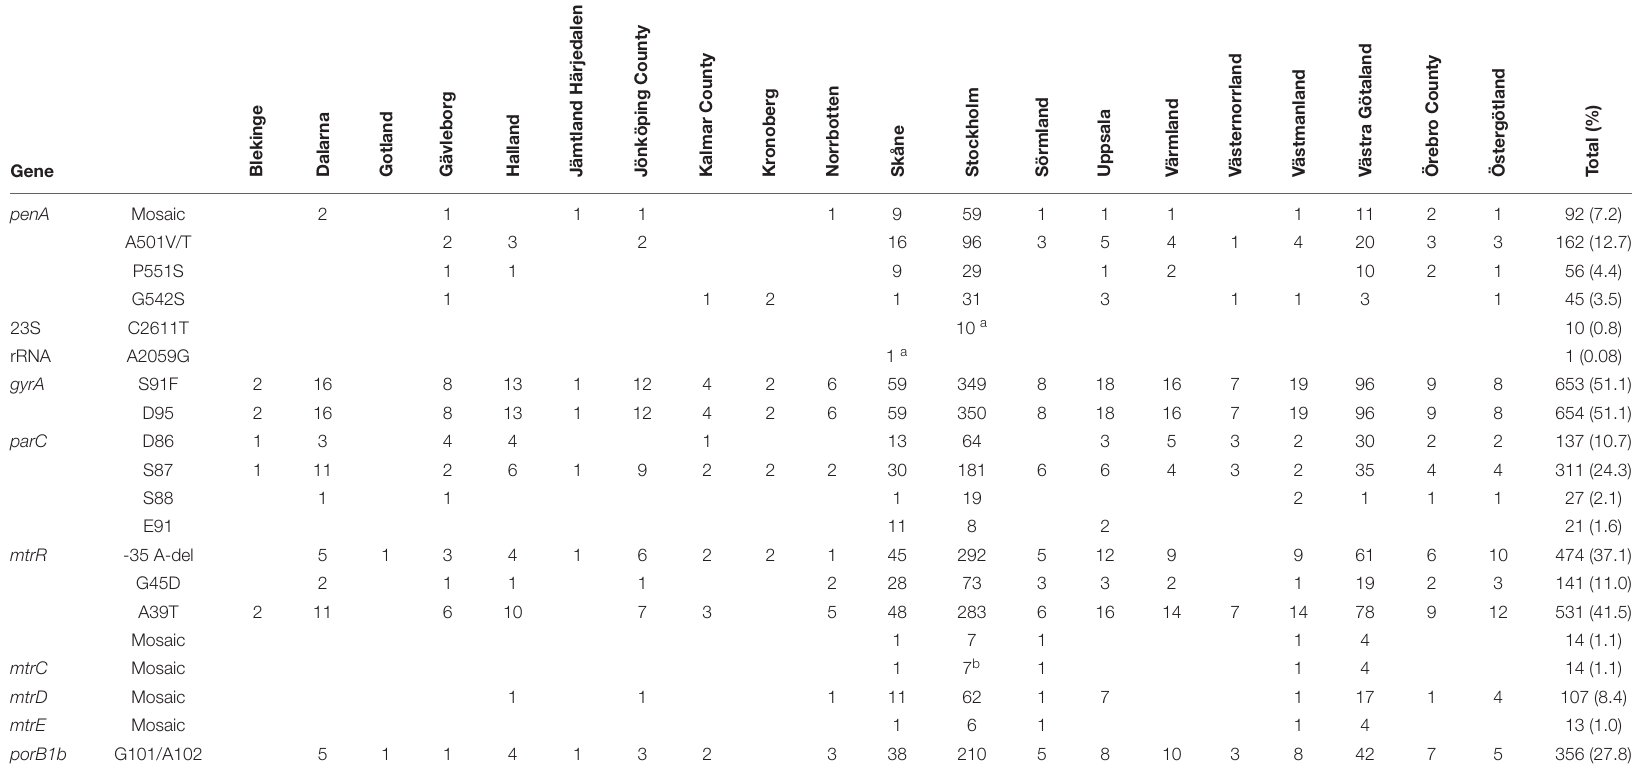
TABLE 2 | Main antimicrobial resistance determinants in Neisseria gonorrhoeae isolates ( n = 1279) cultured in Sweden in 2016, by regional council.